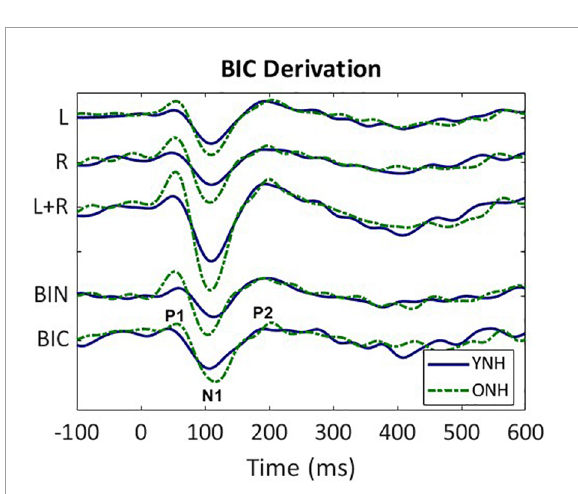
FIGURE2 Derivation of the binaural interaction component (BIC). Grand average responses (arbitrary units) for each listener group (YNH–blue solid, ONH–green dashed); monaural left (L) and right (R) responses, sum of the monaural responses (L + R), binaural (BIN) response in the ITD Zero condition, and the BIC derived from the summed monaural (L + R) minus binaural (BIN) responses. The BIC is labeled with the three main peak components (P1, N1,